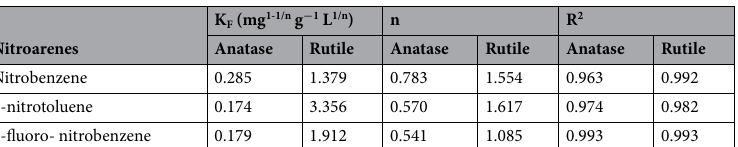
Table 1. The relative adsorption capacity (K F ) was obtained from Freundlich adsorption isotherm, log q e = log K F + 1/n (log C e ), where q e is the equilibrium concentration of nitroarenes, C e is final concentrations of nitroarenes, n is intensity of adsorption, and R 2 is the regression coefficient.